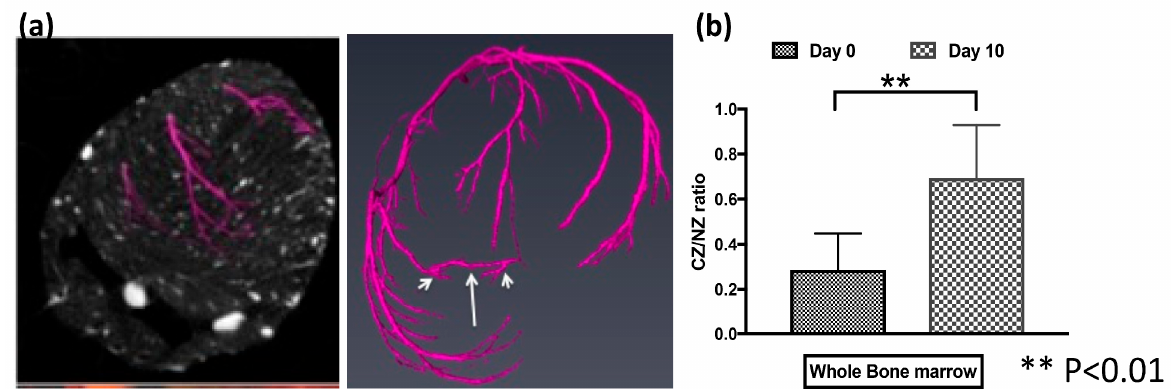
Figure 7. Whole BM cells contributed to coronary collateral growth in the chimeric rats during repetitive ischemia (RI). ( a ) micro-CT images of rat collaterals, marked by arrows. ( b ) The difference in coronary blood flow was measured by contrast echo during inflation of the occluder in the normal zone (NZ) and collateral dependent zone (CZ) at day 0 (before RI) and day 10 (after RI). The CZ/NZ ratio increased after RI, suggesting collateral growth.